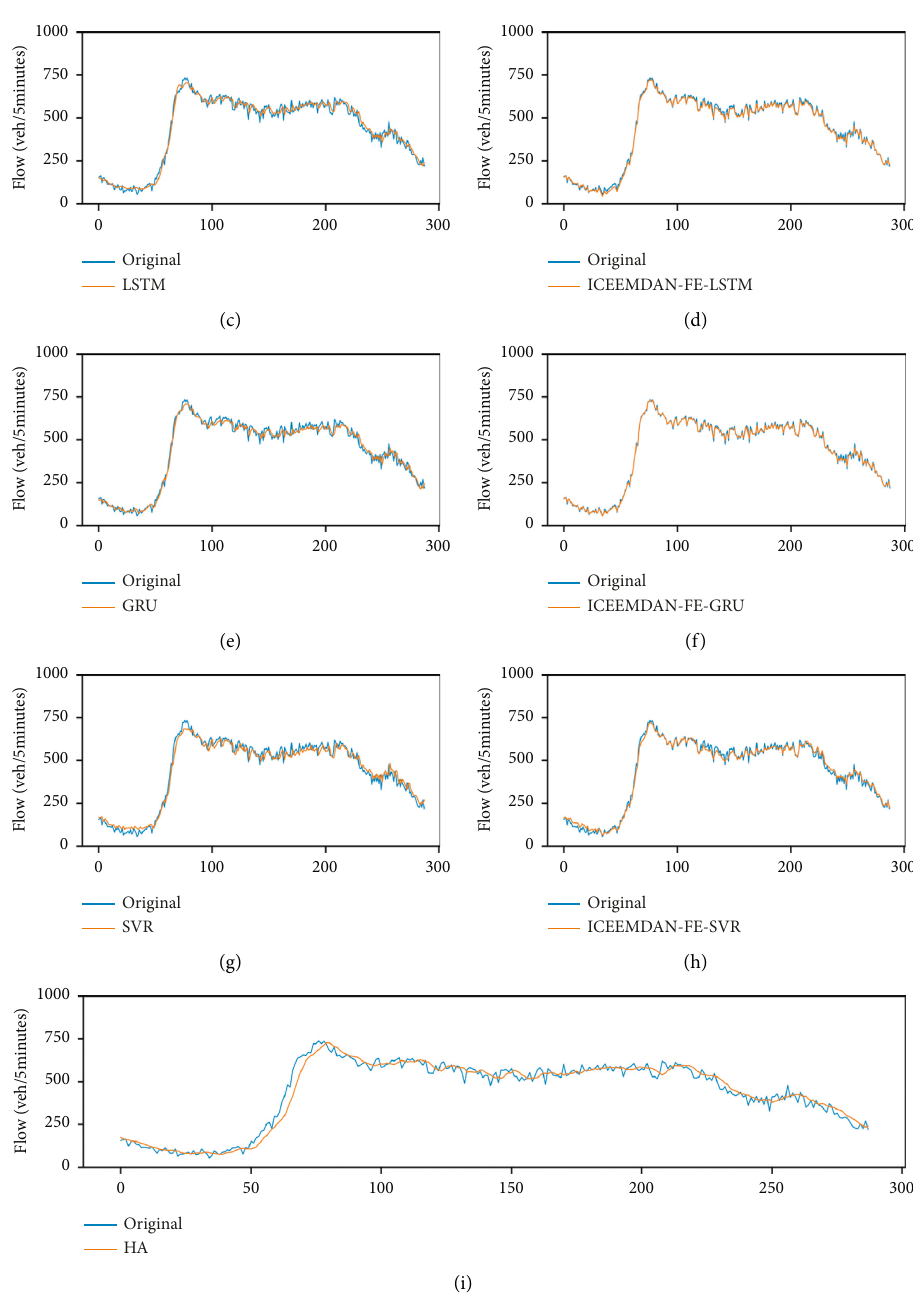
Figure 13: One-step ahead prediction performance comparison on Aug 31, 2018, of different algorithms of 717490.